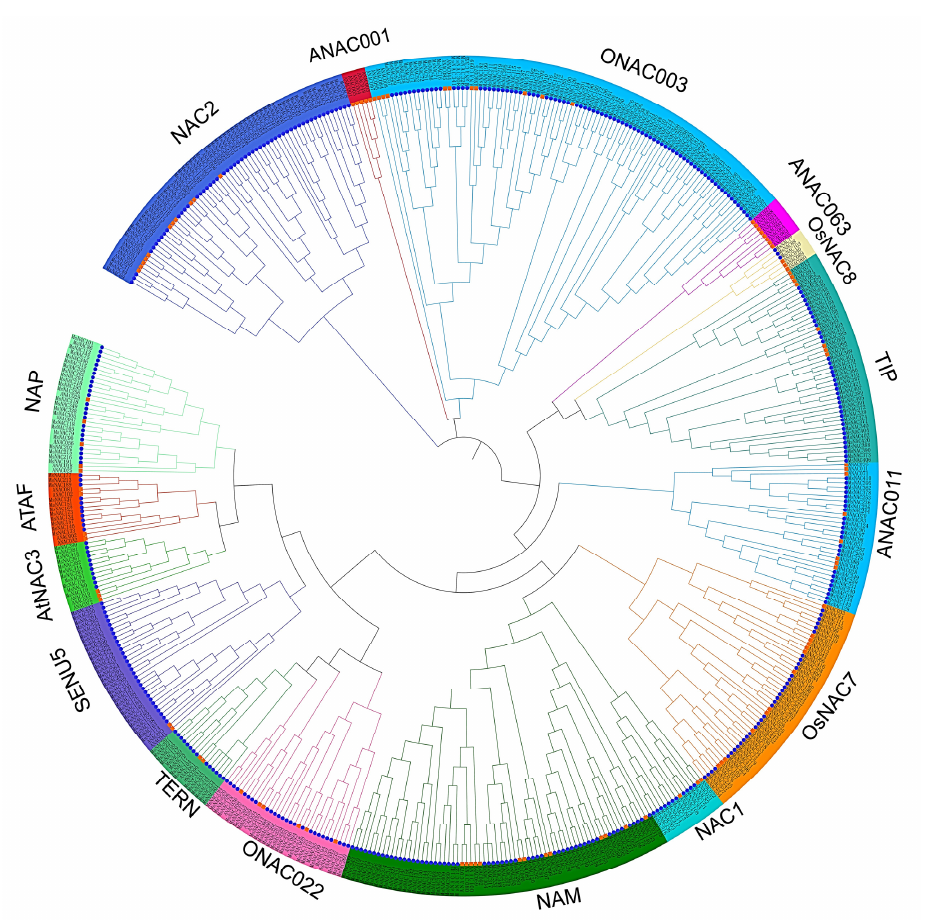
Figure 3. The phylogenetic tree constructed from 421 MsNAC proteins in M. sativa and 105 AtNAC proteins in A. thaliana . Different colors indicate different groups, and 16 groups were